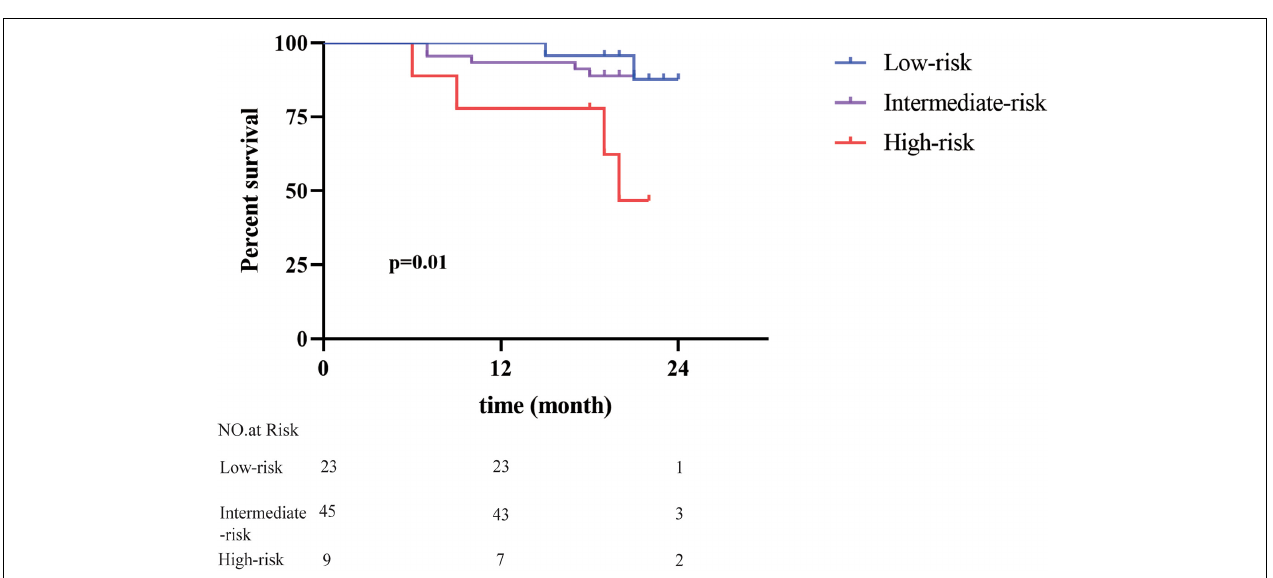
FIGURE 3 | Validation of predictive value of the seven-gene signature. The risk scores of 77 patients with HCC in an independent cohort were calculated. Patients with different risk scores had distinct overall survival after radical resection ( p =